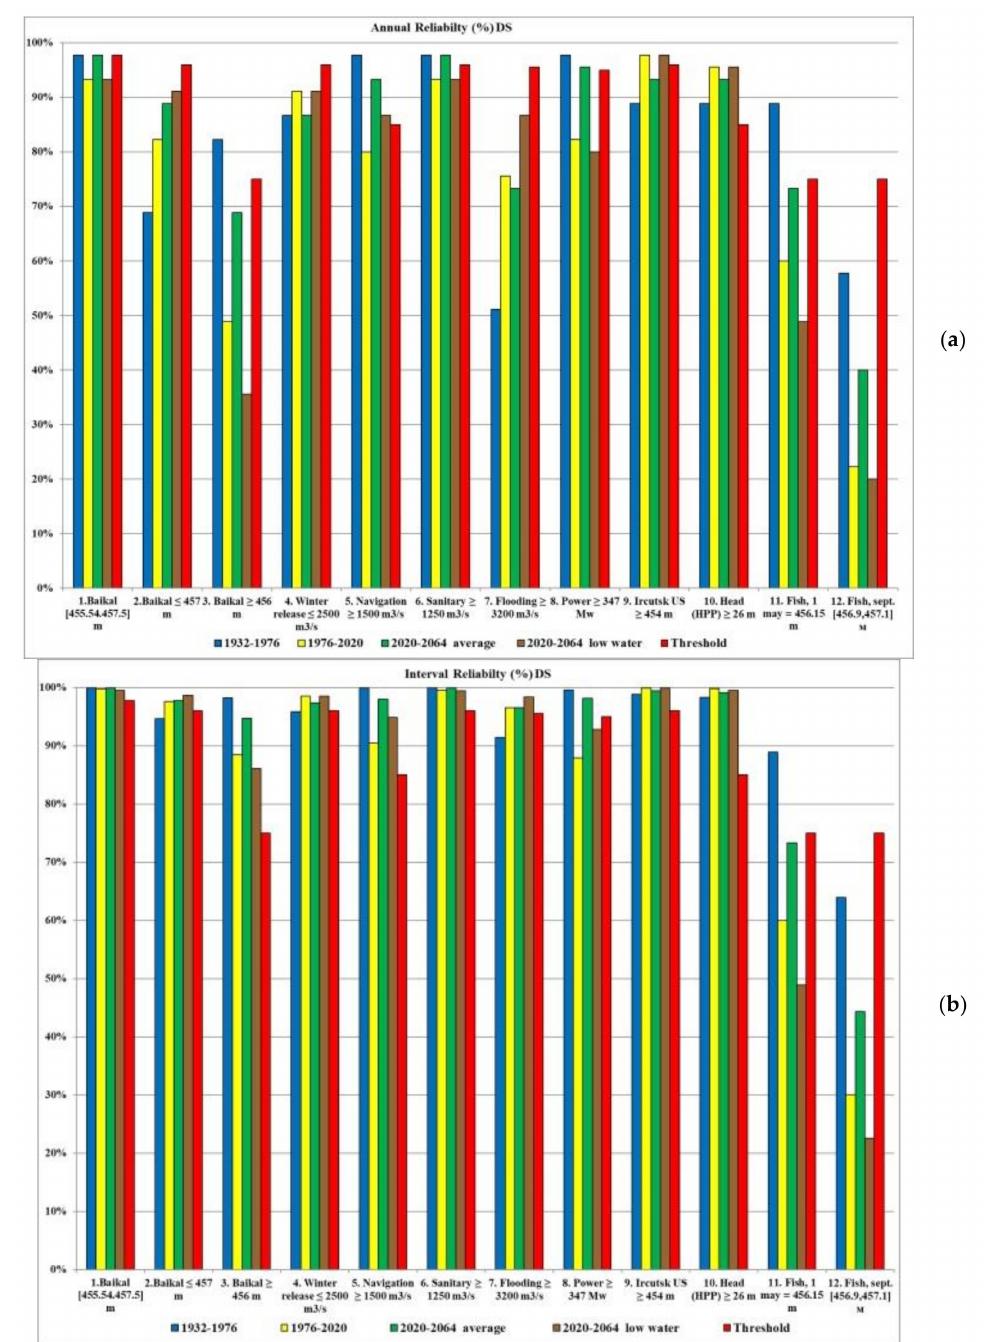
Figure 11. Annual ( a ) and interval ( b ) indicators of reliability when WRC uses DS for different time